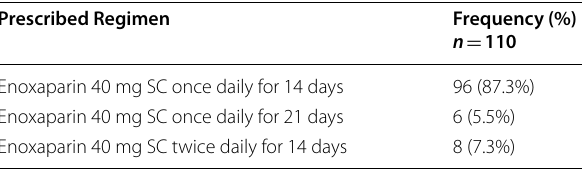
Table 3 Frequencies of Prescribed Regimens in patients who Table 4 Number of patients experienced VTE and